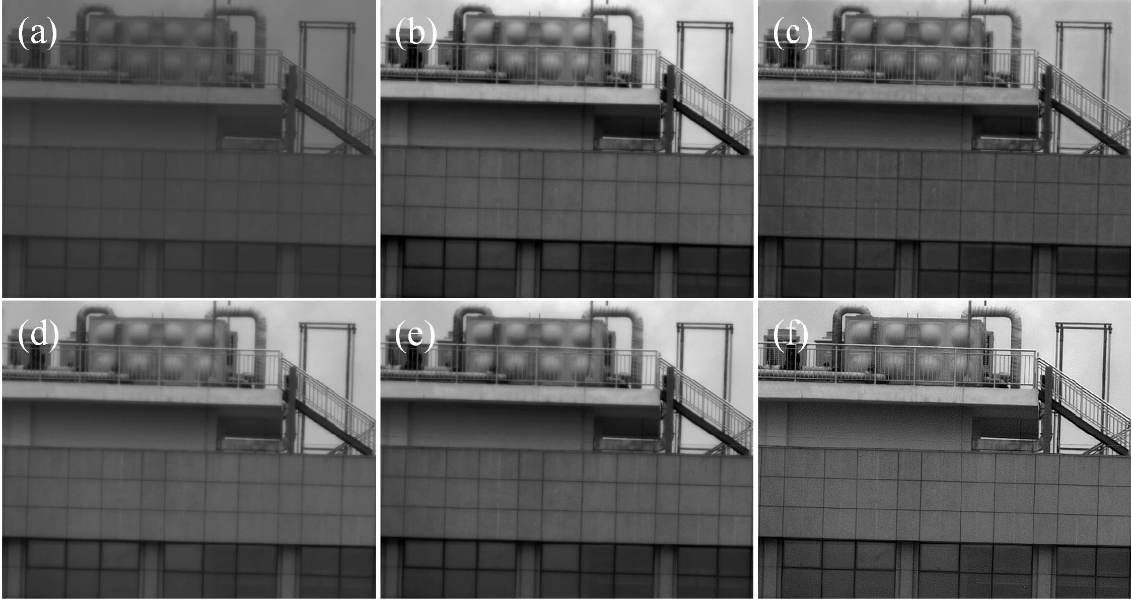
Figure 12. Enhancement results of Image 3: ( a ) input image; ( b ) PE; ( c ) BF&DDE; ( d ) GF&DDE; ( e ) FGF&PE; ( f ) proposed method.